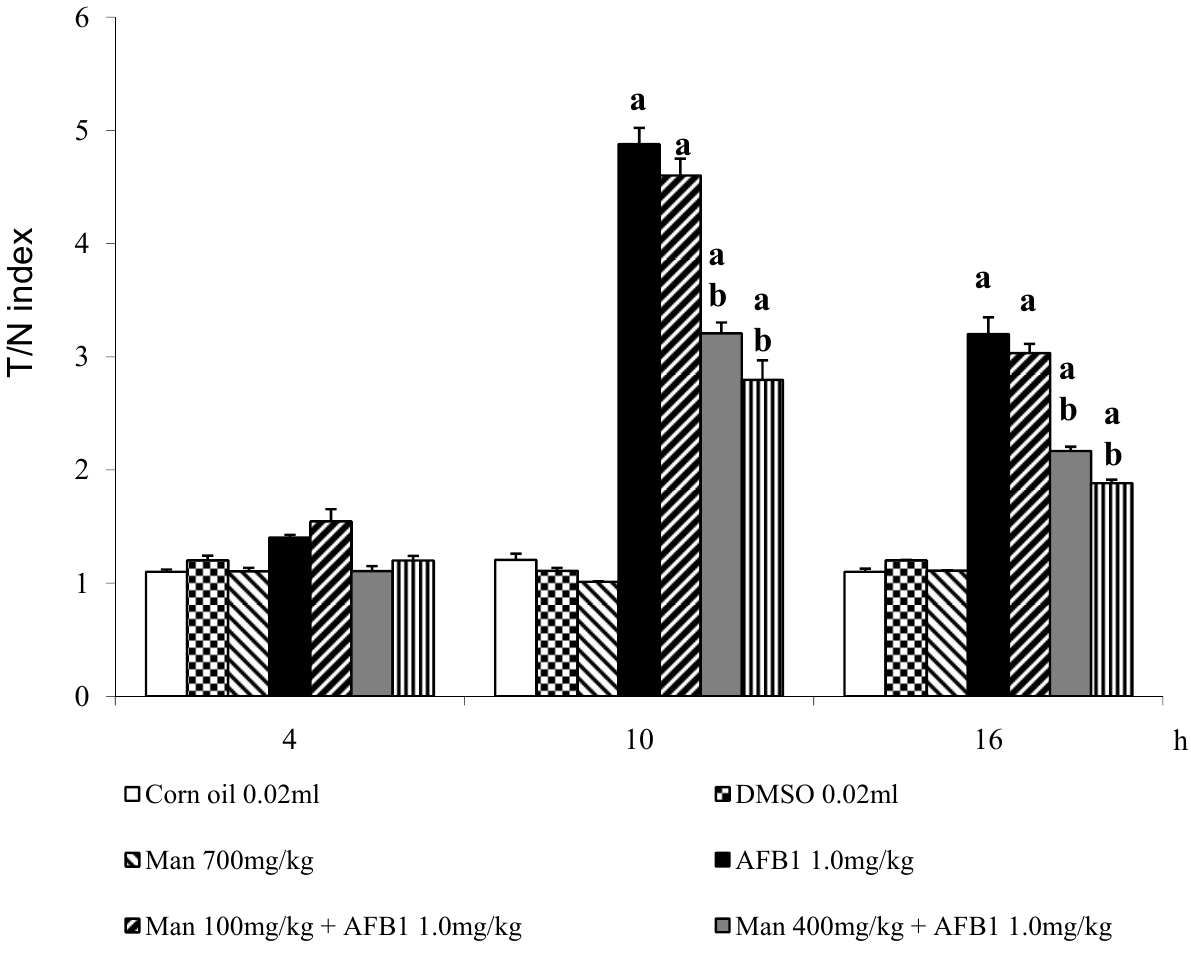
Figure 1. Antigenotoxic effect of α -mannan (Man) against the DNA damage induced